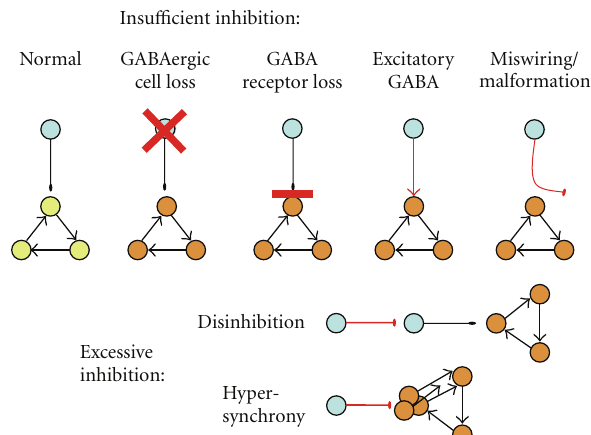
Figure 2: Schematic depiction of simple models through which dysregulation of GABA A receptor-mediated inhibition can increase the activity of neuronal networks, potentially generating seizures. GABA inhibition can fail when GABA or GABA A receptor expres- sion is low, when GABA depolarizes neurons, or when miswiring and mistargeting of synapses occur. Excessive GABA inhibition may trigger seizures by disinhibiting target cells, or via excessive syn- chronization of the neurons in the epileptogenic focus. Please note that the e ff ects of dysregulated GABA signaling in more complex neuronal networks, especially in the presence of abnormal circuitry or with specific pathologies, may di ff er. In such cases a combination of the above models may be applicable at di ff erent sites of the epileptogenic network rendering the pharmacological e ff ect of a GABAergic agonist not completely predictable by a single model. Furthermore, shunting inhibition may explain situations where GABAergic drugs silence excessive excitatory network activity, in neurons with depolarizing GABAergic